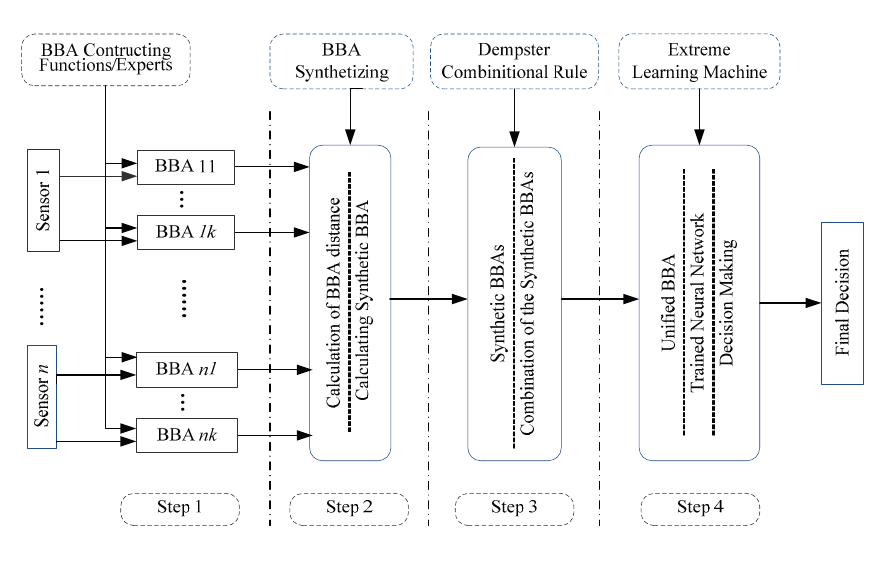
Figure 1. Process of the proposed evidential multisensor data fusion